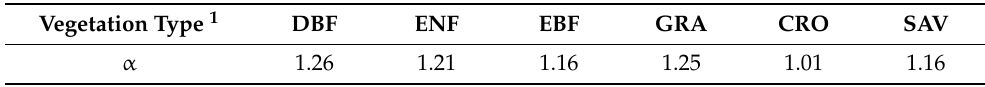
Table 3. The enhancement factor of the LUE under diffuse radiation conditions. Vegetation Type 1